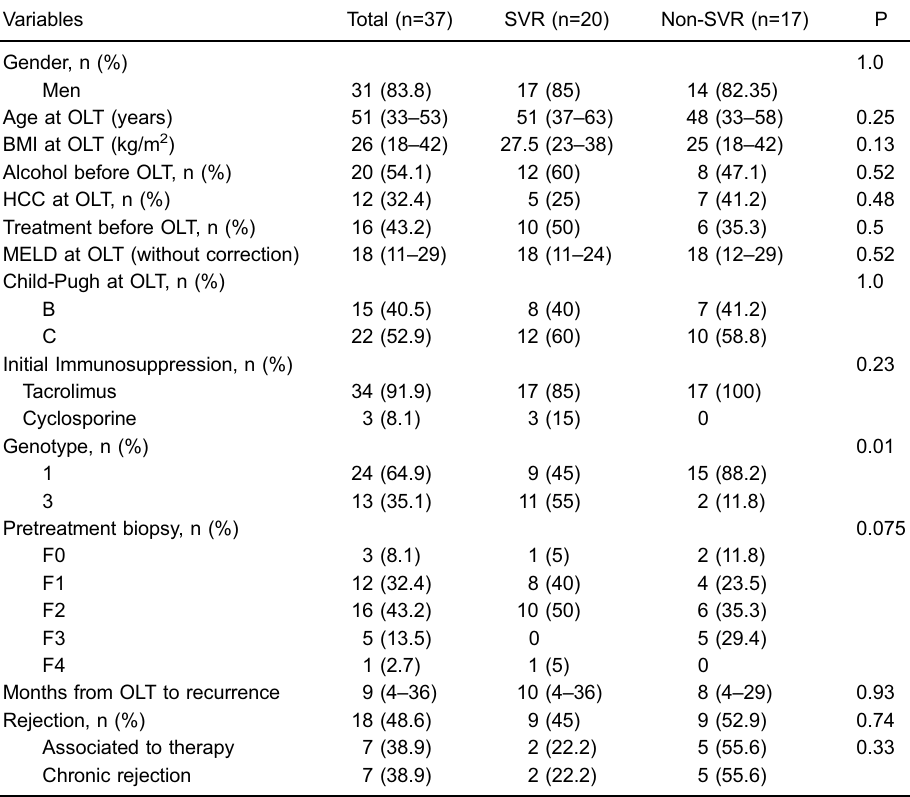
Table 2. Characteristics of the patients who completed recurrent HCV treatment after orthotopic liver transplantation.